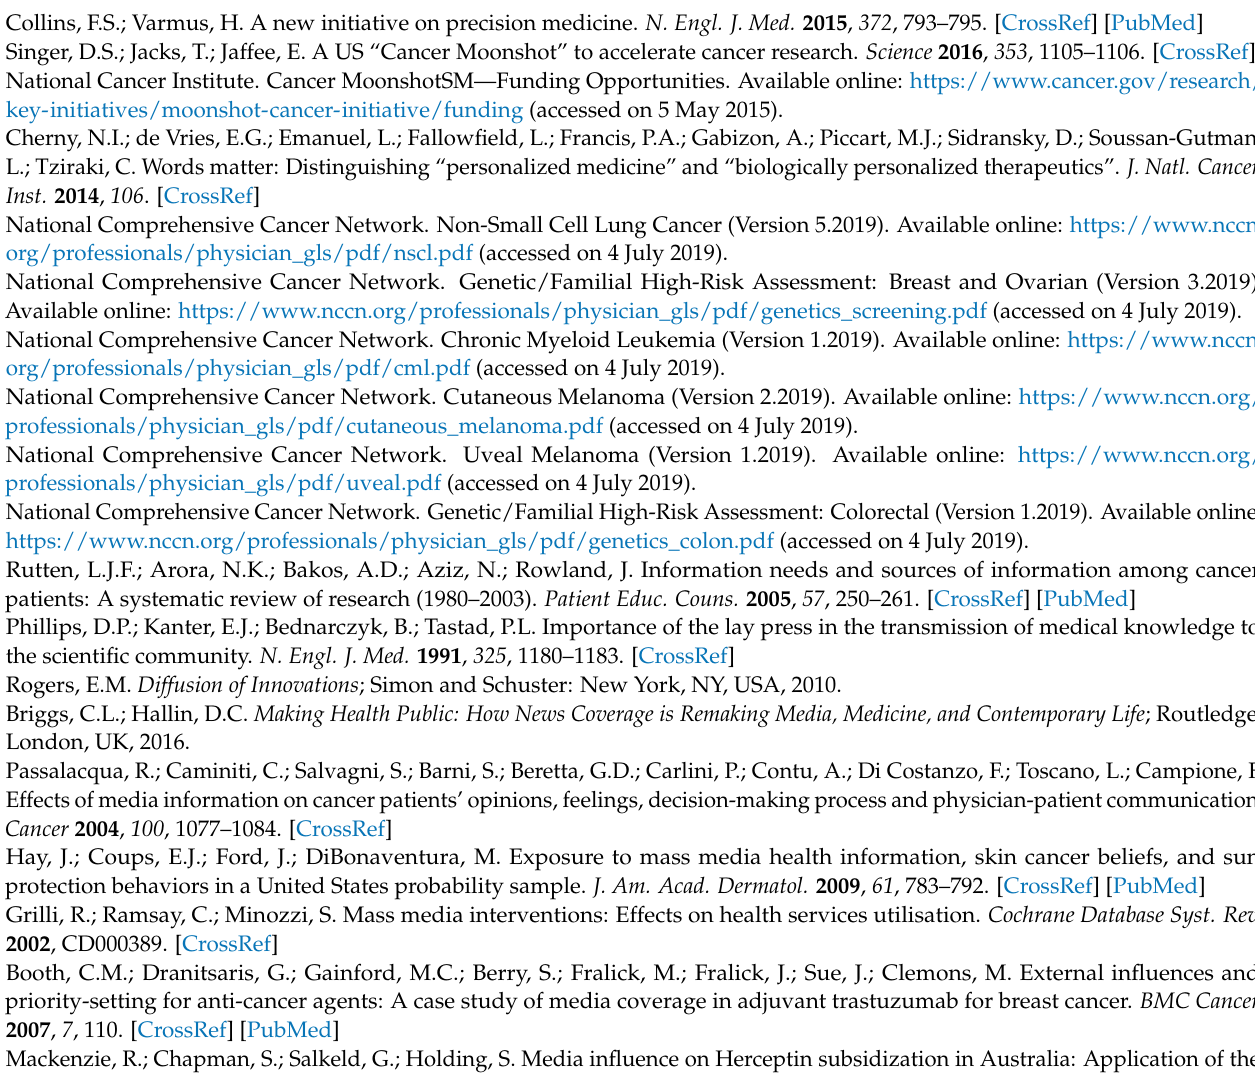
Figure S1: Genomic technologies reported (n = 287), Supplemental Results: “Other” Category Classi-